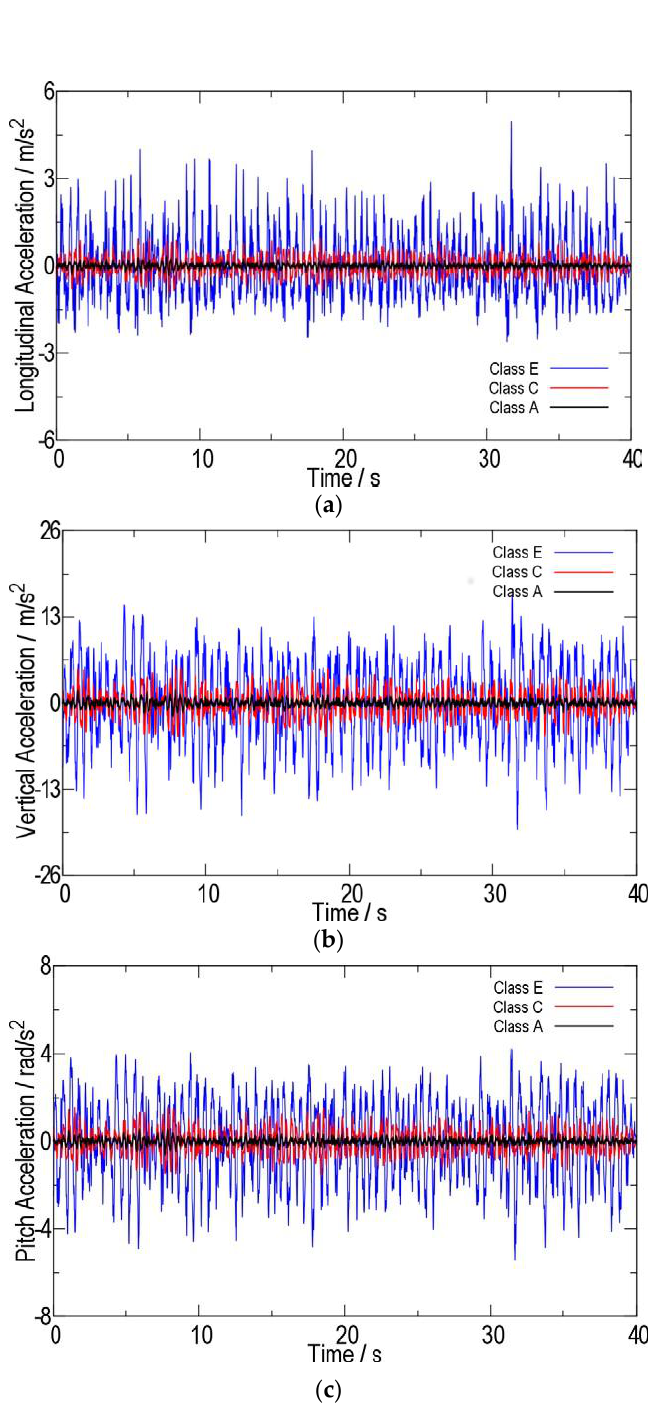
Figure 4. ( a ) Longitudinal, ( b ) vertical, and ( c ) pitch angle accelerations of point A on the missile vehicle when driving on Class A, C, and E roads.